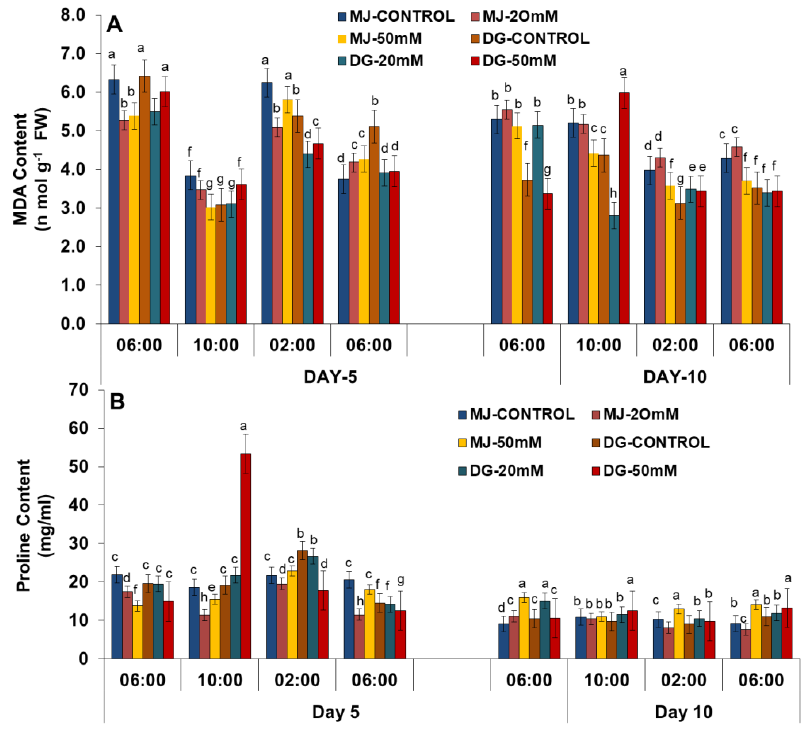
Figure 3. ( A ) MDA content and ( B ) proline content in spinach genotypes Delhi green (DG) and Malav Jyoti (MJ). Results are presented for the controls (MJ control; DG control), 20 mM of NaCl treatments (MJ-20 mM; DG-20 mM), and 50 mM of NaCl treatments (MJ-50 mM; DG-50 mM). Sampling was performed (on the basis of circadian cycle) at 4 h intervals which were at 6 am, 10 am, 2 pm and 6 pm on both day 5 and day 10 of salinity stress. Vertical bars indicate mean ± S.E. for n = 3. Means with different letters are significantly different at p ≤ 0.05 according to the Tukey’s studentized range test. Data for day 5 and day 10 are shown separately and the colors of the bars correspond to treatments, which remain the same for different